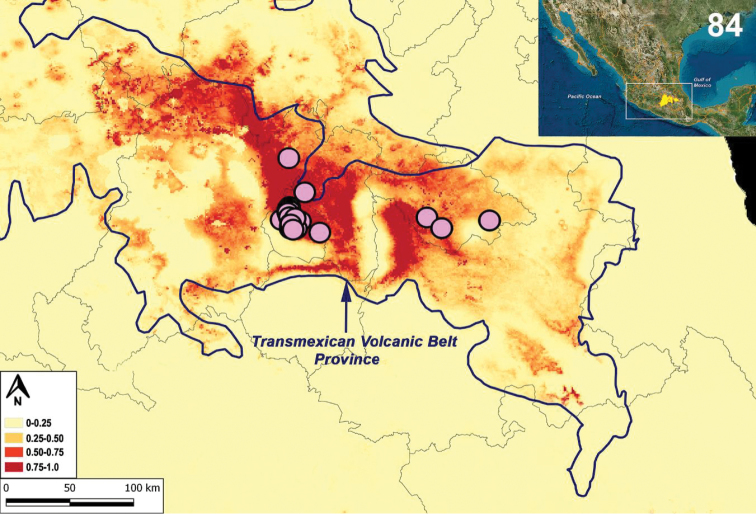
Ecological niche modeling (ENM) under Maxent algorithm for Loxosceles
tenochtitlan sp. nov. Colors represent different ranges of probabilities of presence (high probability: 0.75–1.0). Circles represent known records of the new species. Blue lines represent biogeographical provinces proposed by Morrone (2004, 2005).